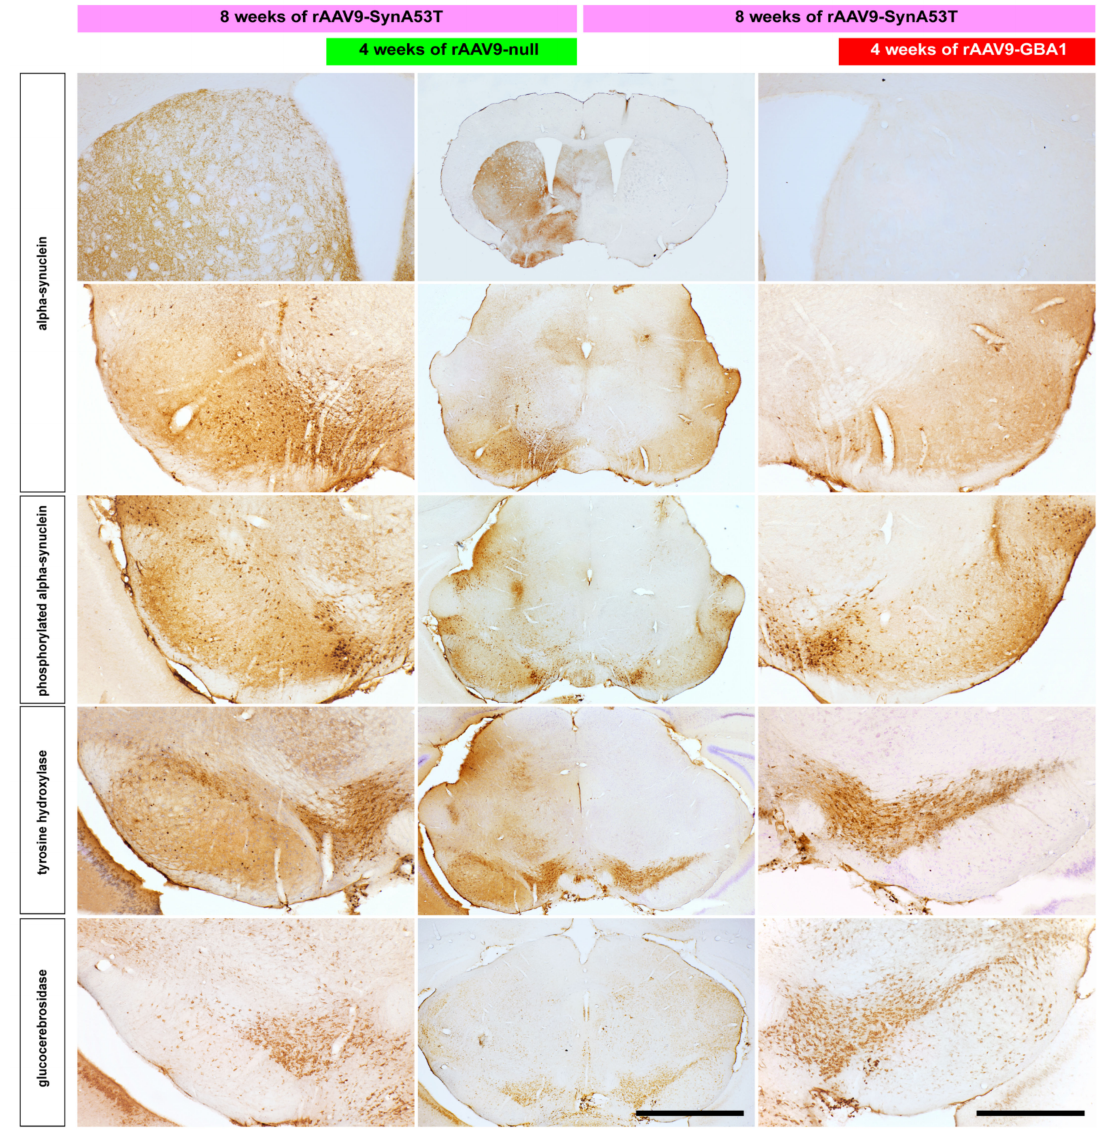
Figure 1. Immunohistochemical stains conducted in mice. Coronal sections through the mice brain taken at the level of caudal mesencephalon and striatum. rAAV-mediated enhancement of GCase activity in the right SNpc resulted in an almost complete clearance of α -syn burden, both at the level of the SNpc as well as in the striatum when compared to the contralateral SNpc where a control-null vector was delivered. Reduction in α -syn burden exerted a neuroprotective effect on the number of TH+ neurons in the SNpc, in keeping with enhanced expression of GCase. Scale bar is 1000 µ m for insets and 2000 µ m in low-magnification panels (4000 µ m when considering the panel showing a coronal section through the